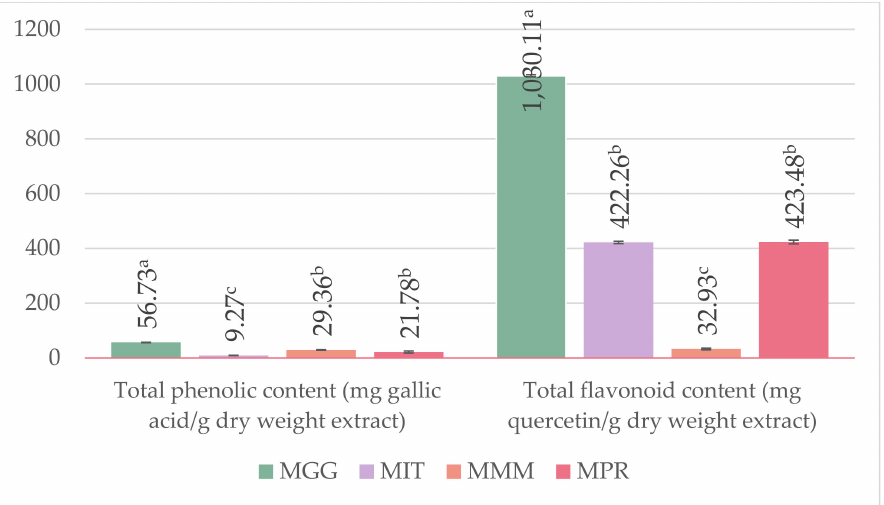
Figure 3. Total phenolic and total flavonoid contents of Mucuna seed extracts. Values are expressed as mean ± SD ( n = 3); a, b, and c show significant differences among samples at p <